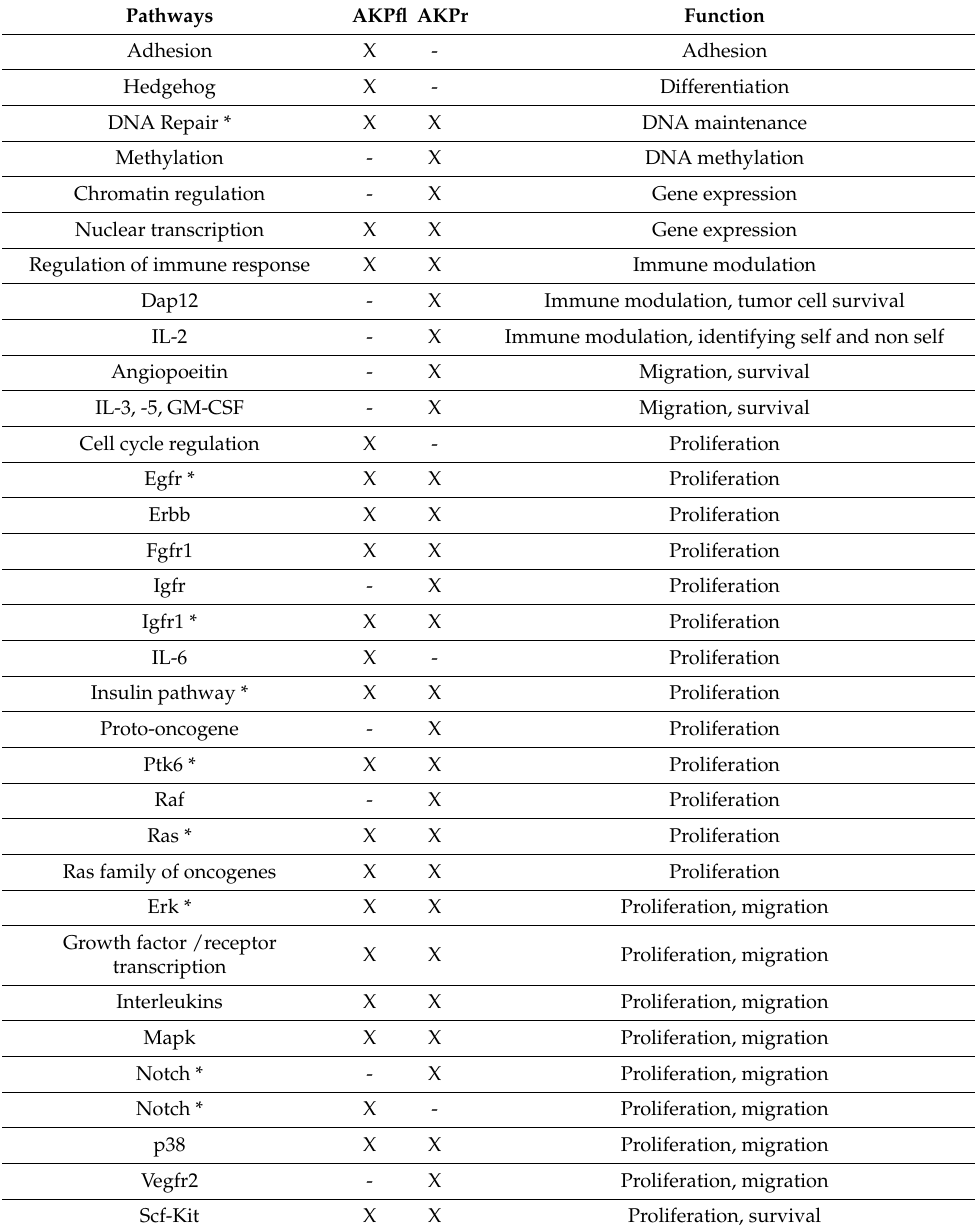
Table 2. Major Altered Pathways in AKPr and AKPfl